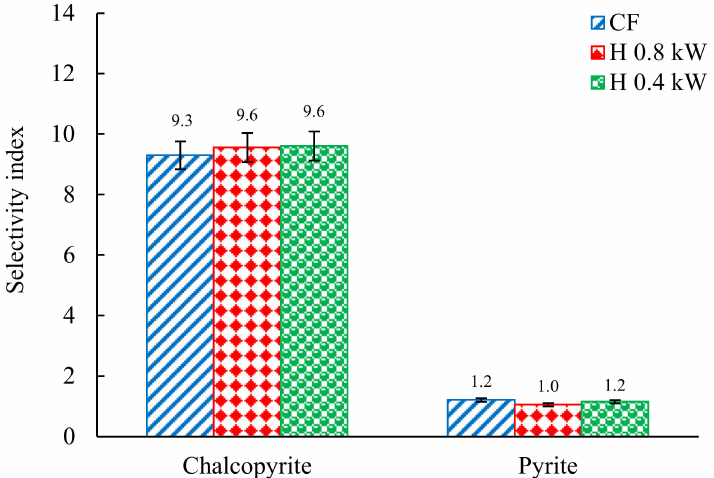
Figure 3. Chalcopyrite and pyrite selectivity indices in the presence and absence of the